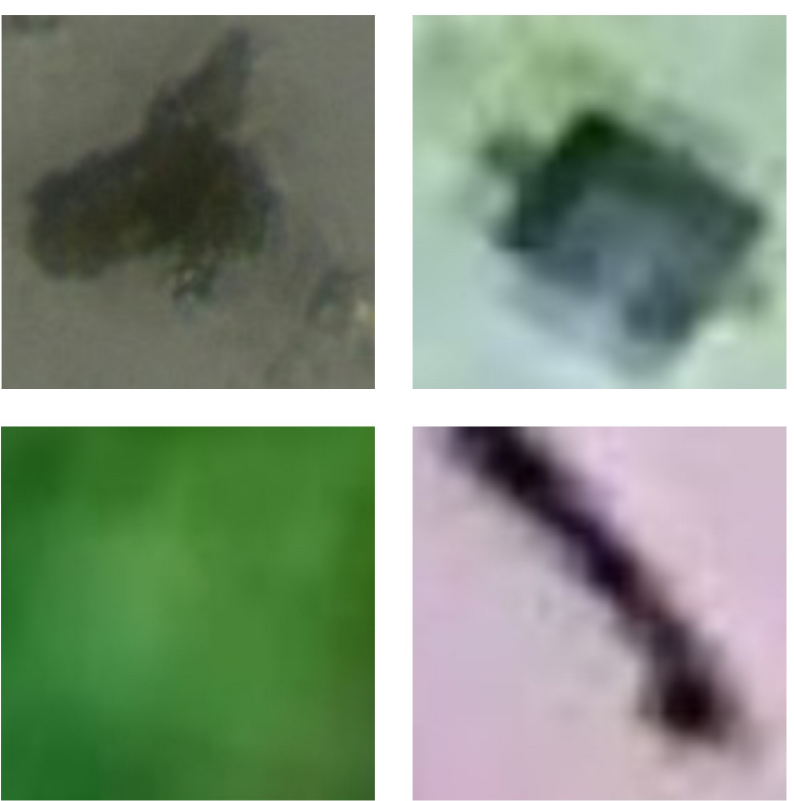
Fig 5. Some examples of samples from the None class. They normally correspond to large pieces of debris or